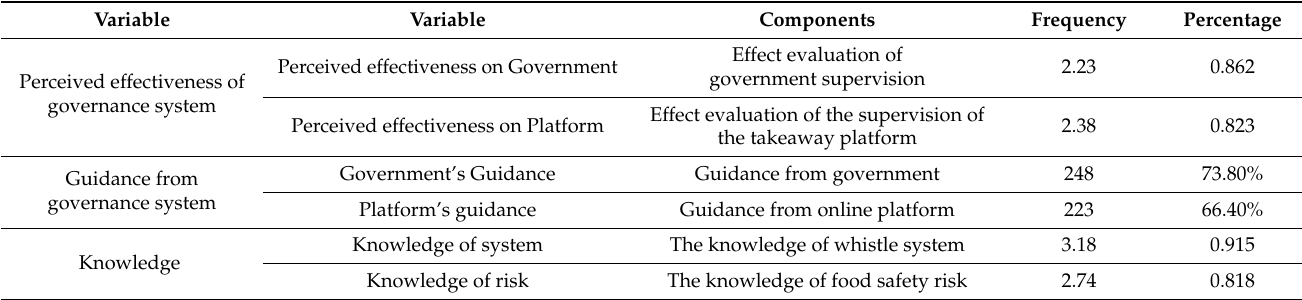
Table 2. Descriptive statistics of explanatory variables.